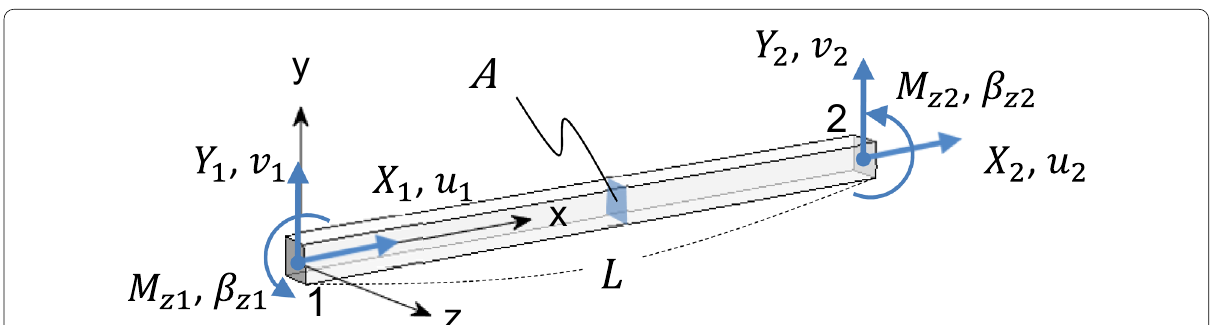
Fig. 7 Two-dimensional beam-rod element used for the finite element method. L : length of the element, A :area of beam, X 1 , X 2 : nodal axial force, Y 1 , Y 2 : nodal shear force, M z 1 , M z 2 : nodal moment around z axis, u 1 , u 2 , v 1 , v 2 : nodal displacement, β Z 1 , β Z 2 : nodal rotation angle around z axis. Subscripts denote the node